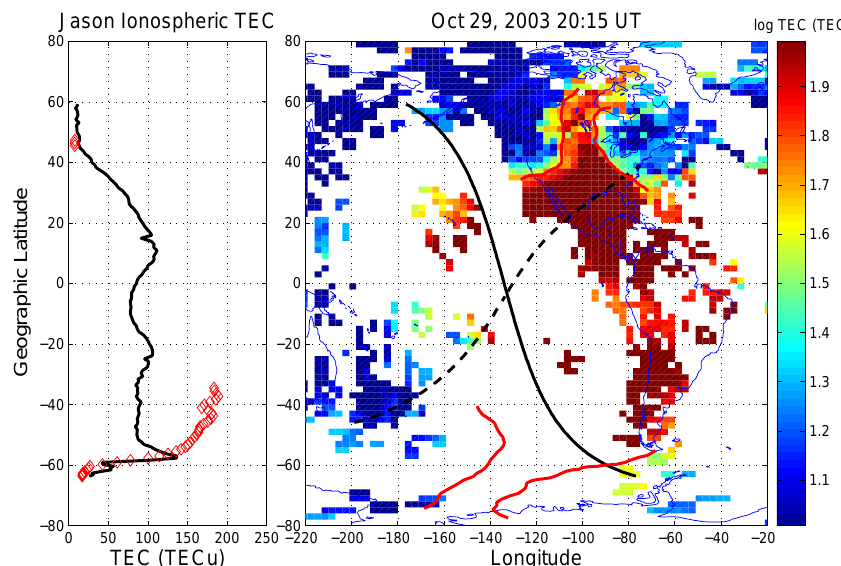
Fig. 3. Whereas the sharp poleward edge of SED, produced by the action of SAPS electric fields, is closely conjugate, the bulge of enhanced TEC at the base of the plume is much more pronounced in the SE U.S.